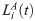
A schematic of our model of overload-based cascading failures on multiplex networks.The system of multiplex networks is composed of two layers A and B (red and blue links respectively), which share the same set of nodes. At each time step t ≥ 0, each node has two load values LiA(t) and LiB(t), defined as the its betweenness centrality in each layer. Each node also has two fixed capacities, defined as CiA=(1+αA)·LiA(0) and CiB=(1+αB)·LiB(0). At the beginning, the node with the largest total load LiA(0)+LiB(0) is attacked. This leads to the redistribution of loads among the remaining nodes. At the next time step, according to some pre-defined overload rule, some other nodes will also fail due to overload. This causes a cascading process of overload failures, until no more overload happens.